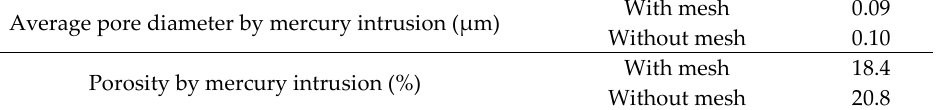
Figure 7. Porosimetry properties obtained by mercury intrusion of cement mortar applied to lightweight concrete block substrate, with and without mesh. Table 5. Cement mortars–capillary pores–cumulative mercury